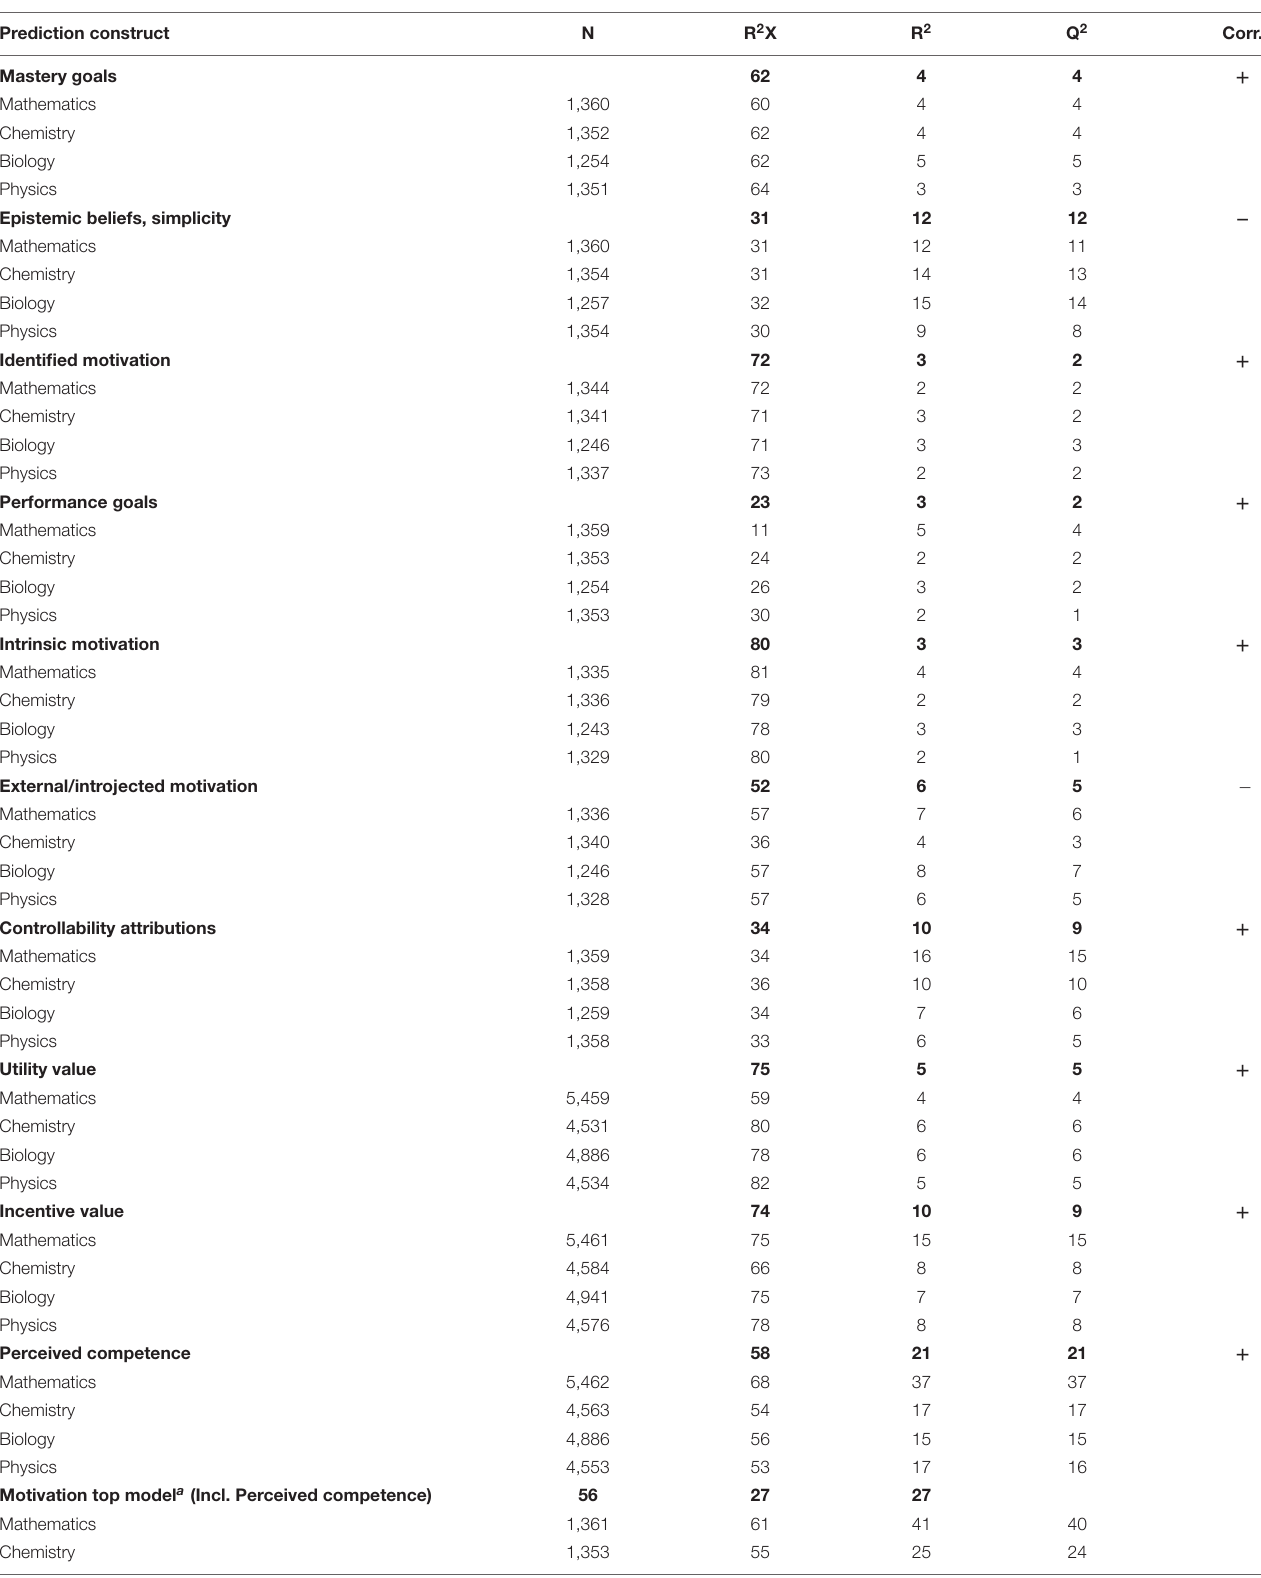
TABLE 4 | Overview of OPLS models, predicting Students’ plausible values in each subject. Prediction